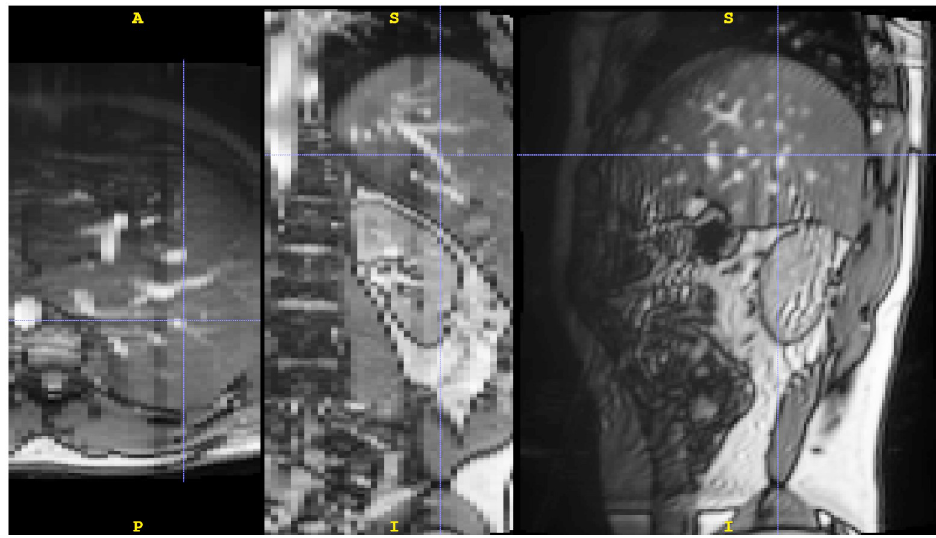
Fig 7. Axial, coronal and sagittal slices of a reconstructed volume. The images gradation curve was altered globally to enhance contrast for better viewing only. In the axial and coronal orientation, one can see that our method is capable of reconstructing smooth and continuous volumes from sagittal